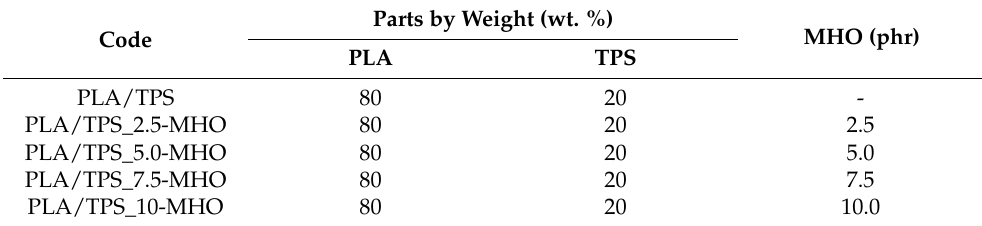
Table 1. Compositions of the PLA/TPS blends with varying amounts of MHO.